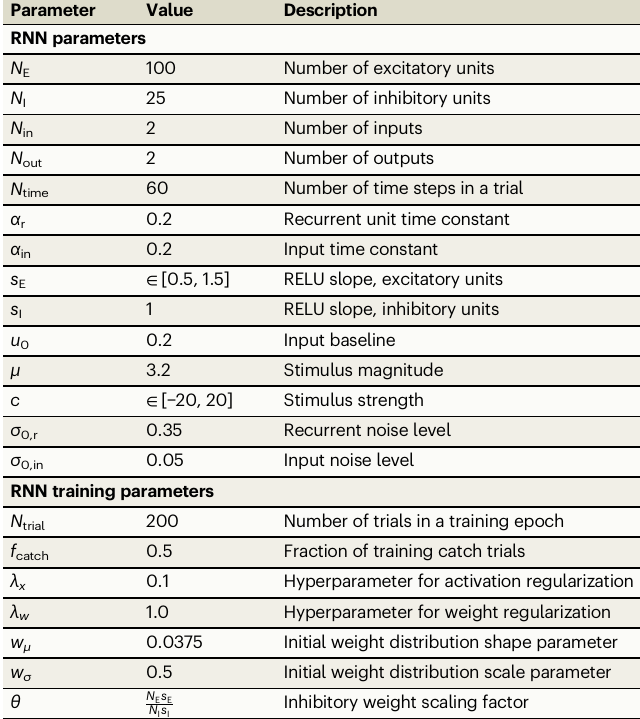
Table 2 | Recurrent neural network